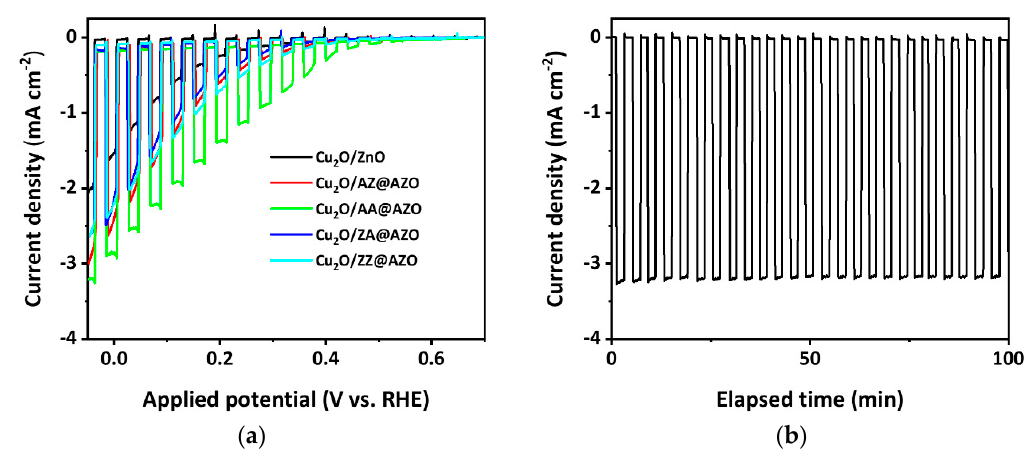
Figure 6. ( a ) Linear sweep voltammetry properties of prepared Cu 2 O/overlayer photocathodes; ( b ) Long-term stability test of Cu 2 O/AA@AZO/TiO 2 /Pt photoelectrode at 0 V RHE in a 1 M Na 2 SO 4 solution buffered with KH 2 PO 4 and H 3 BO 3 under AM 1.5G illumination.